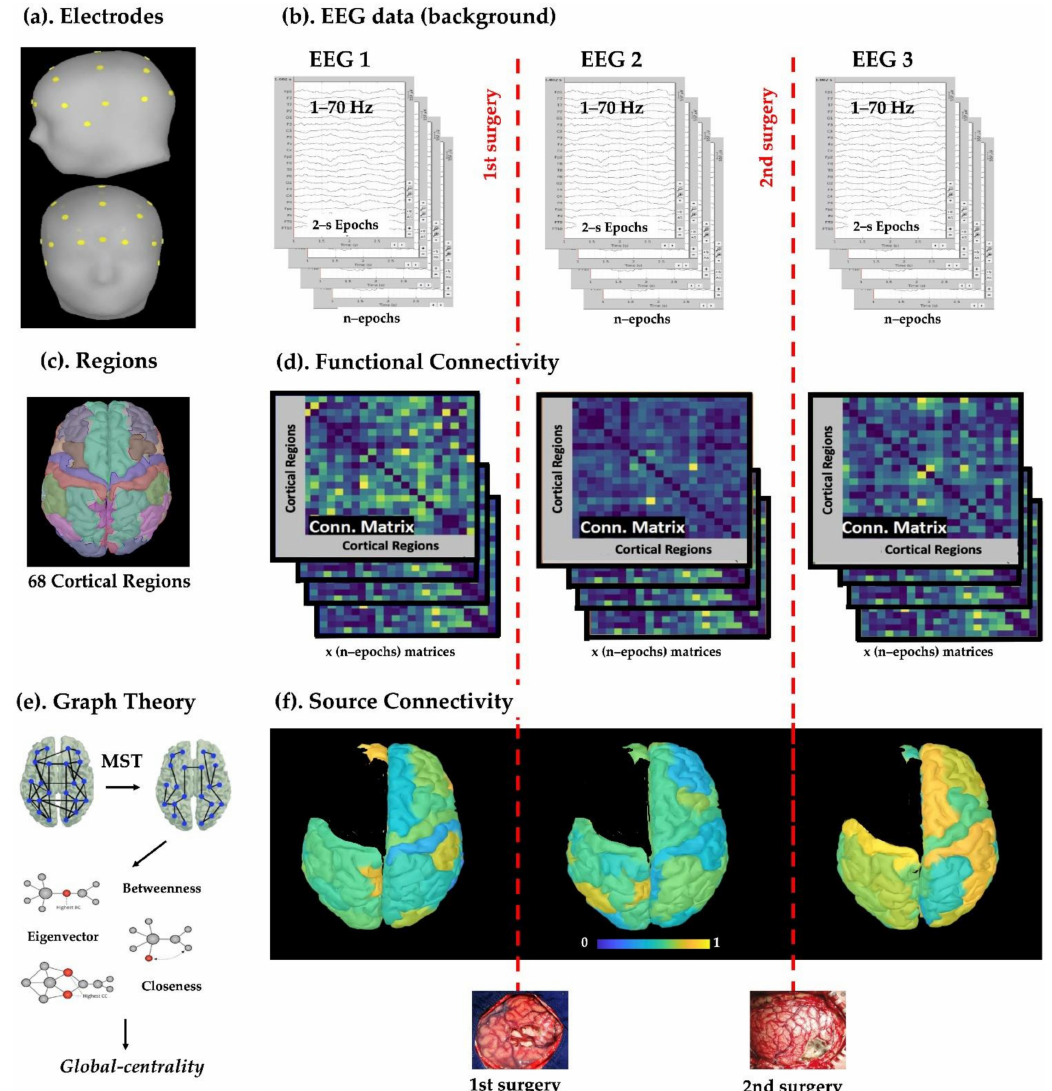
Figure 1. Outline of the data analysis process. ( a ) We retrieved conventional EEG data and the patient’s MRI at the time of the EEG (to build the head model), on which electrodes were positioned according to the international 10/20 system); ( b ) interictal sleep EEG data without interictal discharges and artifacts were selected (“background activity”). We analyzed three EEGs per patient for the repeated surgery group (EEG1—before first surgery; EEG2—between surgeries; EEG—after second surgery) and two EEGs per patient for the seizure-free group (EEG1—before surgery; EEG2—after surgery). These EEG data were segmented into multiple 2 s epochs. ( c ) Each patient’s cortical surface was parcellated into 68 regions of interest (ROIs) defined by the Desikan–Killiany atlas. ( d ) From each EEG epoch, a functional connectivity matrix was computed (amplitude envelope correlation method). ( e ) A graph and its minimum spanning tree (MST) were then built from each matrix, then three centrality measures (betweenness, closeness, and eigenvector) were extracted, normalized, and averaged, obtaining a unique comprehensive measure of relative centrality (“global centrality”). ( f ) The global centrality was estimated for each cortical ROI (average of all epochs) at each time point (before first surgery, between surgeries, after second surgery). We report here an example of global centrality across all cortical ROIs for patient #2, where yellow and blue colors indicate high and low values,